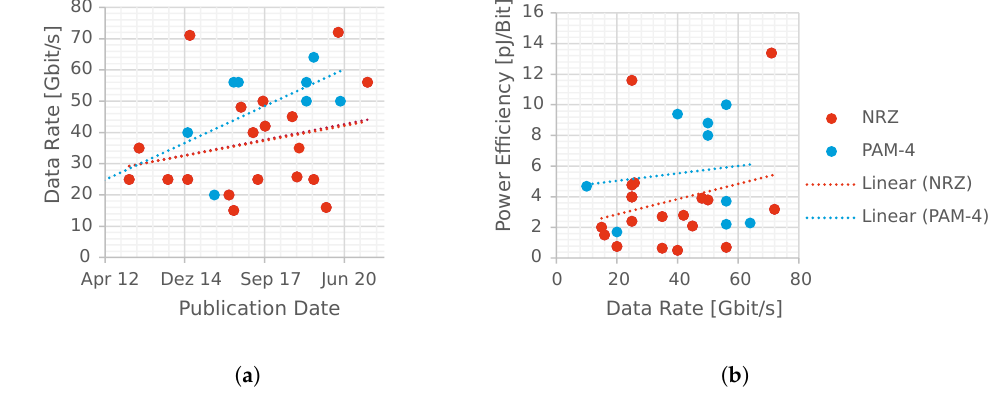
Figure 1. VCSEL Transmitter System ( a ) data rates over publication dates ( b ) power efficiency.